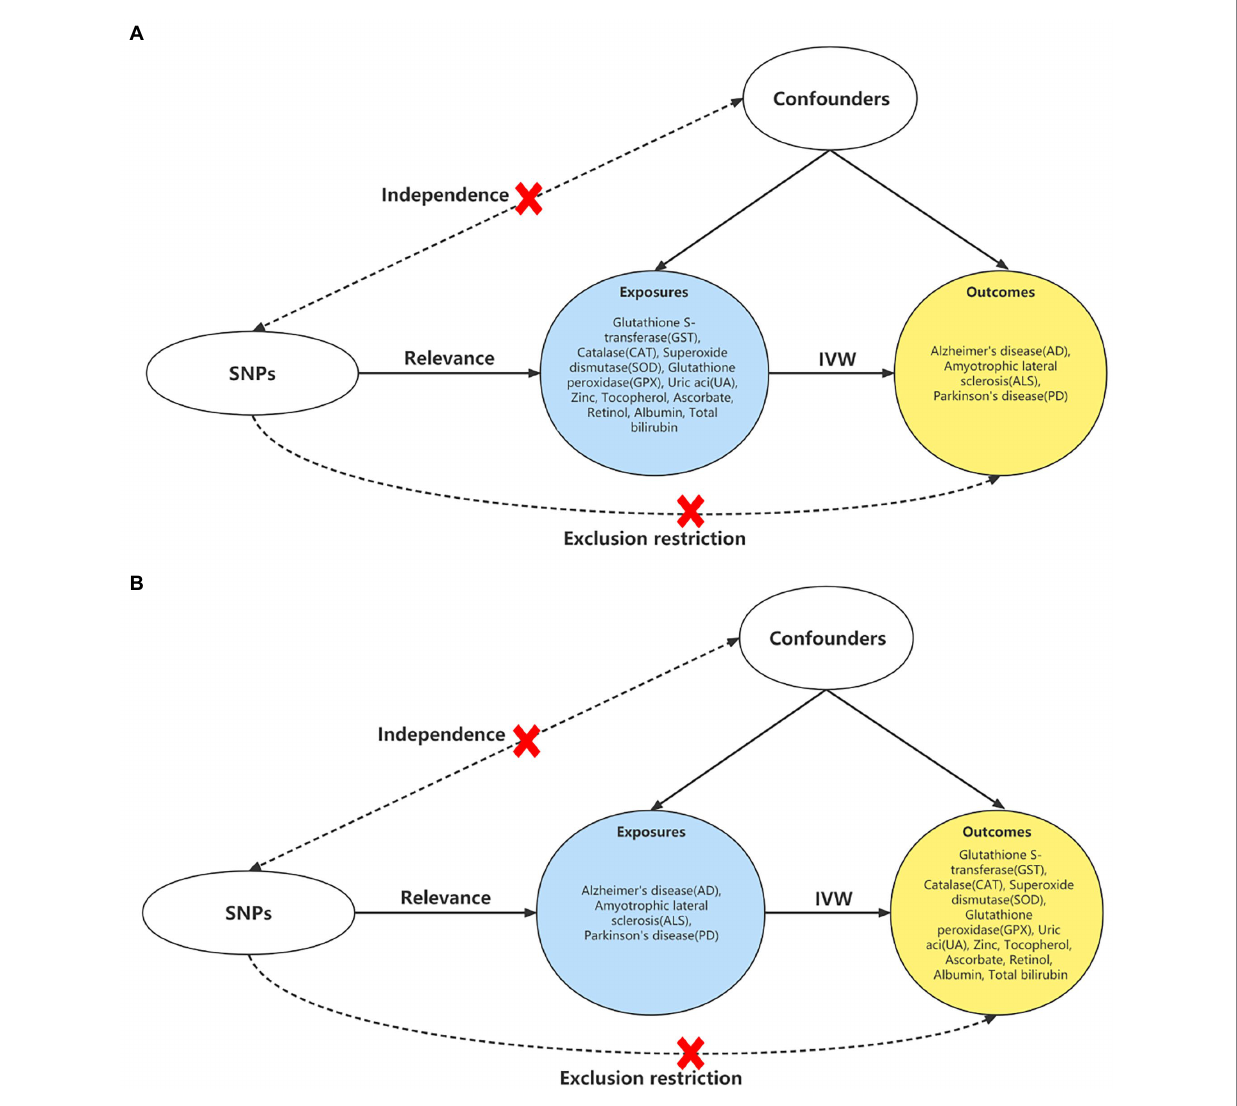
FIGURE 1 Study design of the bidirectional MR. (A) Study design of the causal effect of antioxidant biomarkers on the neurodegenerative diseases. (B) Study design of the associations of neurodegenerative diseases on antioxidant biomarkers. Abbreviations: MR: Mendelian randomization; IVW, inverse variance weighted method; SNP, single nucleotide